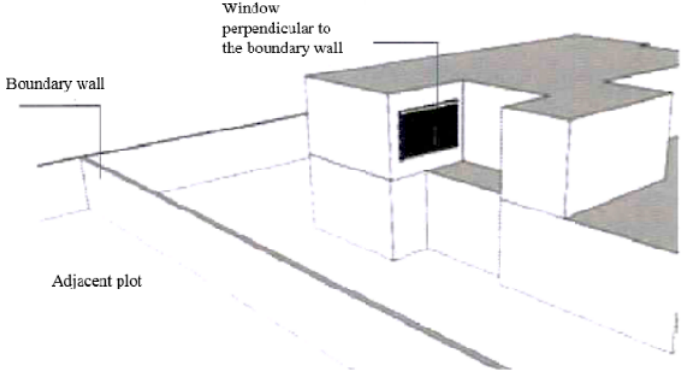
Figure 6 . A window is perpendicular to the boundary wall to achieve privacy (Source: [68]). Figure 6. A window is perpendicular to the boundary wall to achieve privacy (Source: